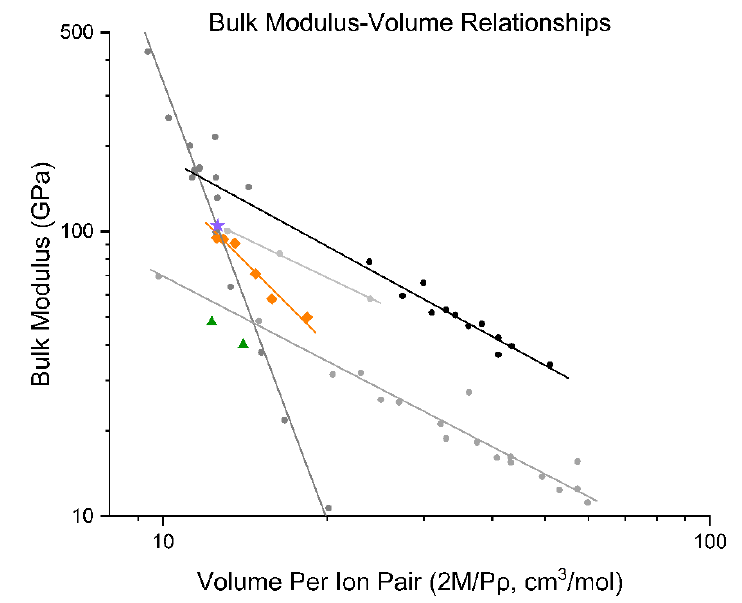
Figure 12. Bulk modulus versus specific volume for simple oxides, alkali halides, fluorites, sulfides, selenides, tellurides, and carbonates. Small circles include data from [48] and [49]. Large purple star is the value for bastnäsite-(La) measured in this study (2M/Pρ = 12.60 cm 3 /mol, K o = 105 GPa), large orange diamonds are carbonates from [49], and green triangles are malachite and azurite from [50,51]. Dark gray line is the oxide trend, black line is the sulfide, selenide, and telluride trend, light gray line is the fluorite trend, medium gray line is the alkali-halide trend, and orange line is proposed carbonate trend.